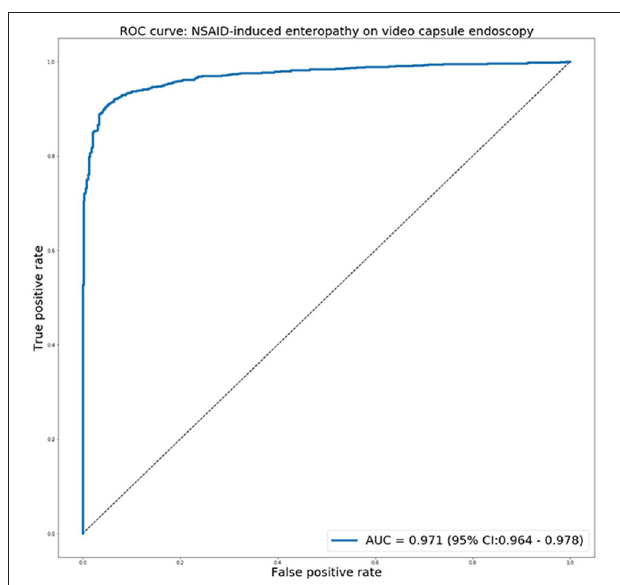
FIGURE 4 | The receiver operating characteristic curve for predicting NSAIDs ulcers using the deep learning